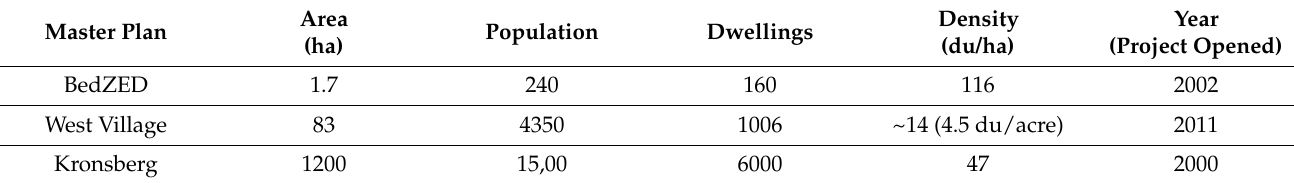
Table 7. Planning characteristics of the worldwide precedent